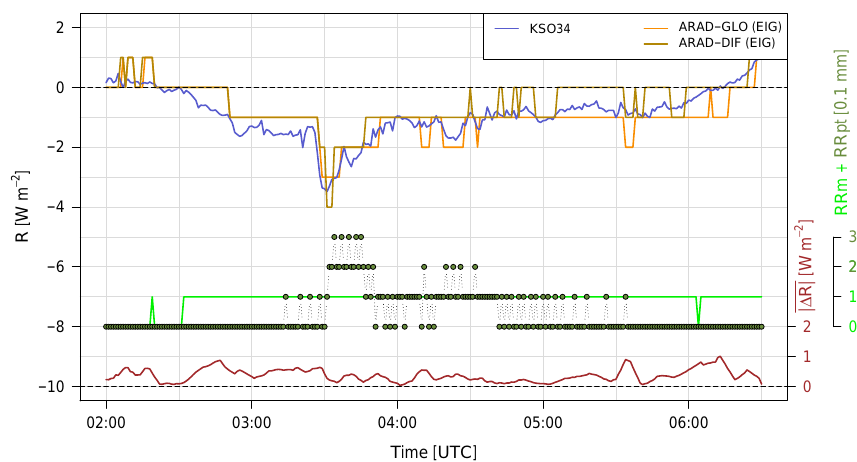
Figure 1. Natural event of a simultaneous decrease of radiation ( R ) measured with three CMP21 pyranometers in various heating and ventilation systems at the Graz University ARAD site on 10 February 2016. System acronyms represent measurements of global (ARAD- GLO) and diffuse (ARAD-DIF) solar radiation at the ARAD platform (with CMP21 pyranometers contained in Eigenbrodt SBL 480, EIG, HV-systems) and global radiation measurements (KSO34) with an additional CMP21 pyranometer (contained in a KSO34 HV-system). The output of the precipitation sensor (RRm) and the ombrometer (RRpt) operated at the co-located meteorological Graz University station is shown along with the radiation measurements. Heavy precipitation started around